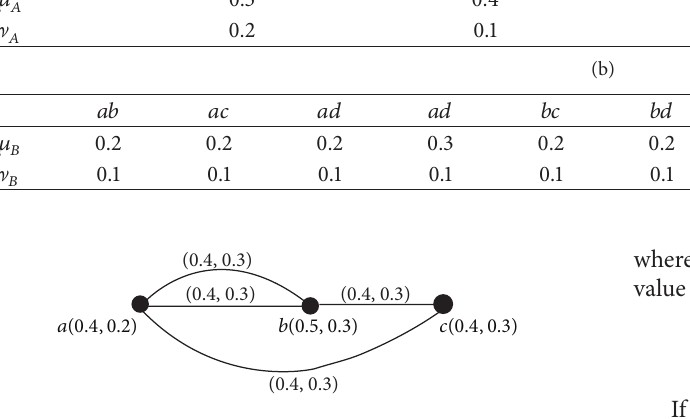
Figure 2: Intuitionistic fuzzy complete